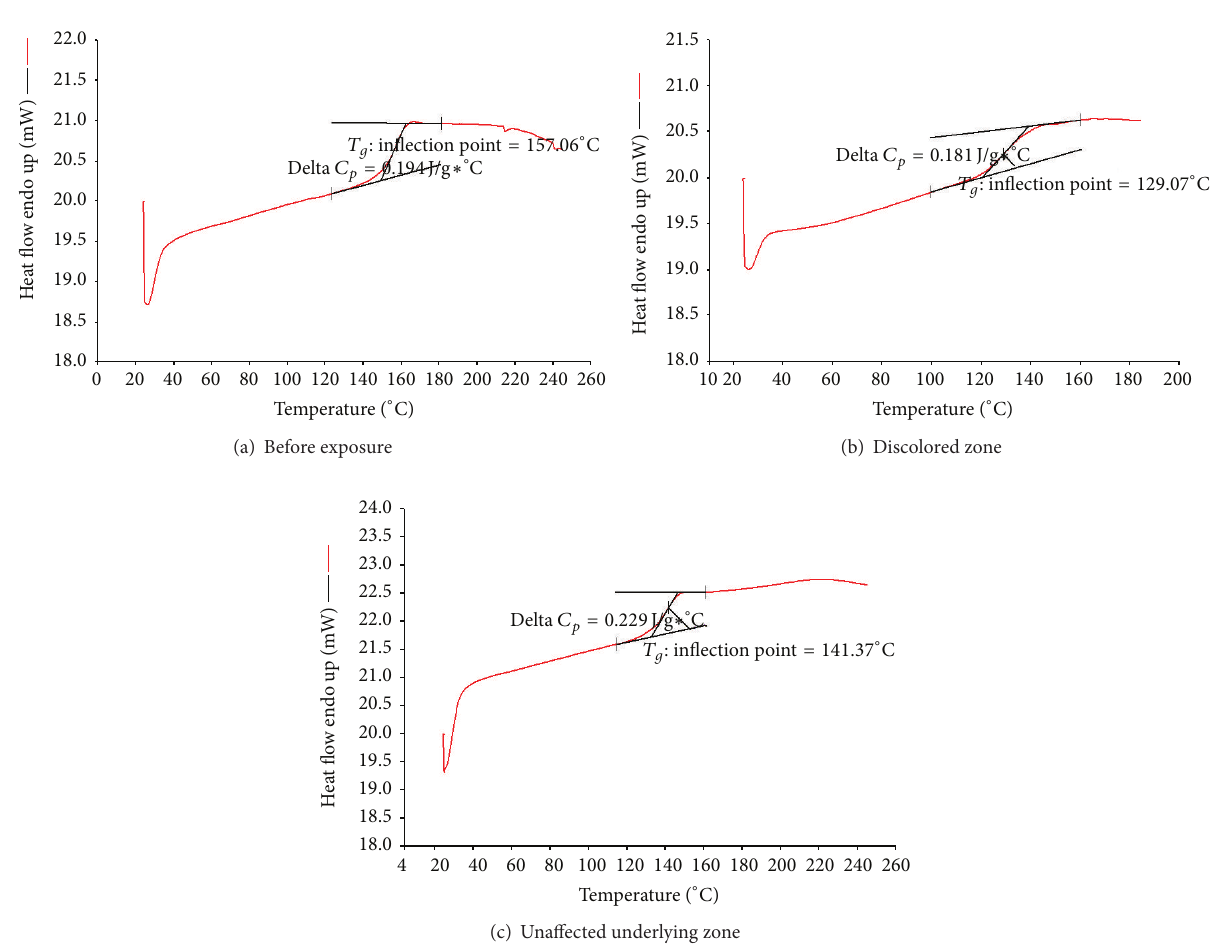
value of the coating on exposure to 5% NaOH solution at high temperature may be attributed to the formation of the deposit layer that retards the diffusion of electrolyte through the